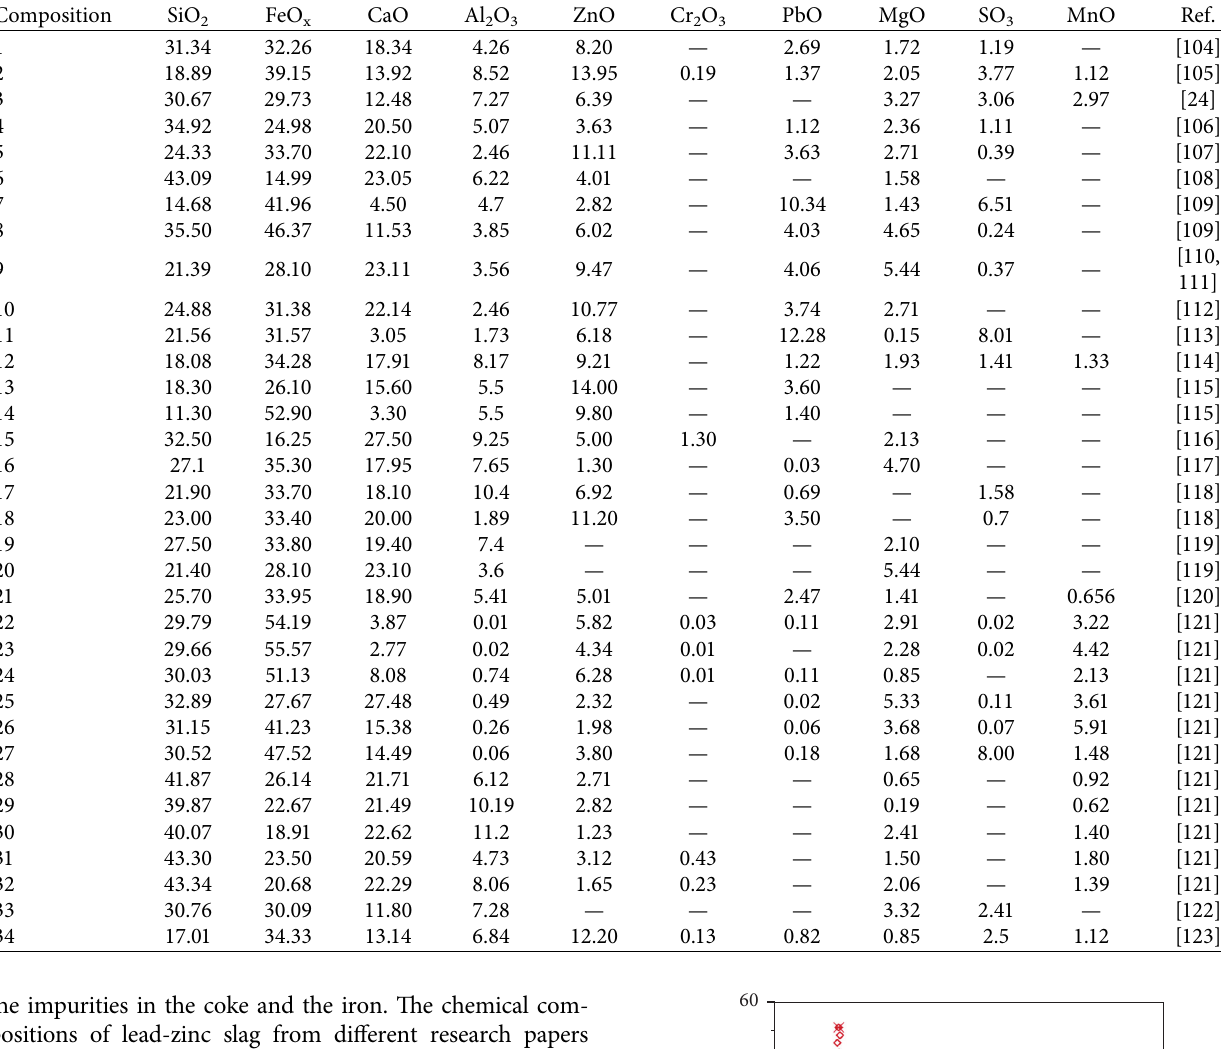
Table 3: Chemical compositions of lead-zinc slag.